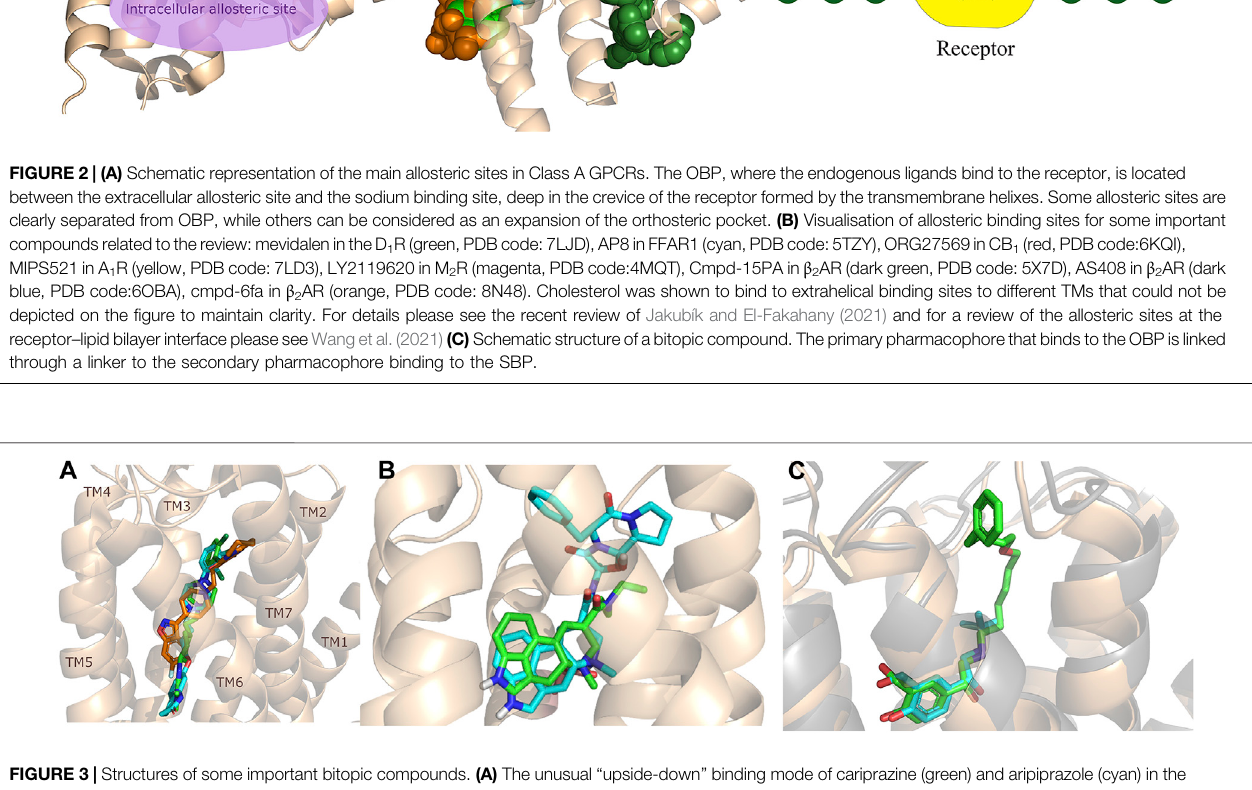
Frontiers in Pharmacology |